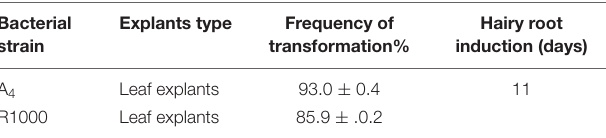
TABLE 1 | Frequency of hairy root induction on leaf explants derived from A. rhizogenes